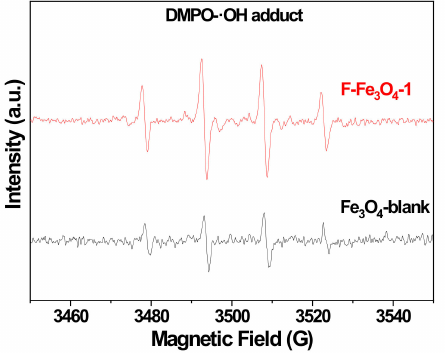
Figure 7. DMPO-trapped EPR spectra. Conditions: F-Fe 3 O 4 -1 or Fe 3 O 4 -blank (0.5 g/L), H 2 O 2 (40 mM), and DMPO (ca. 20